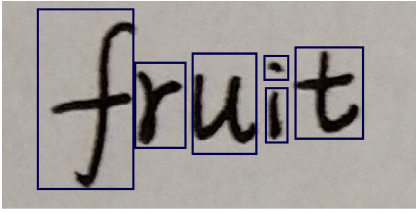
Figure 7. The definition of separate unit.